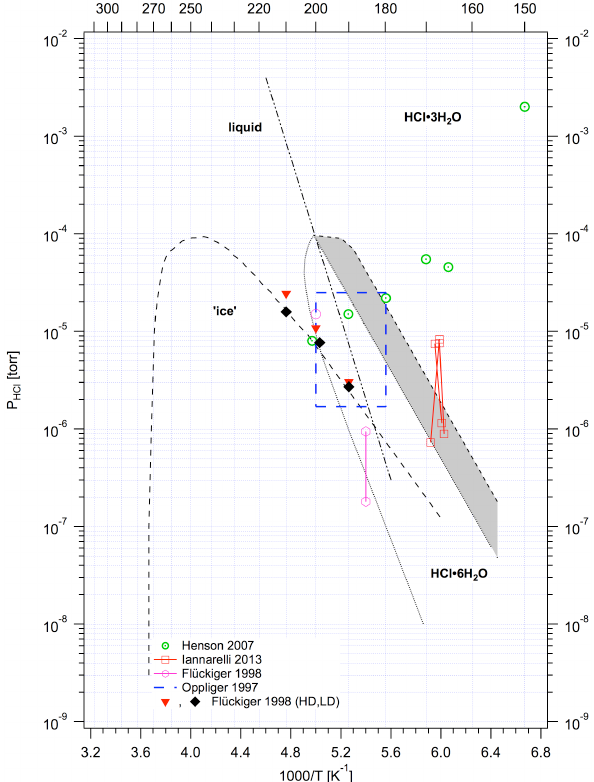
Figure 11. Phase diagram for the binary system HCl/H 2 O. The gray area for the HCl•6H 2 O existence is an extension of the existence area proposed by Iannarelli et al. (2013). The green circles represent HH evaporation whereas the red circles (amorphous HCl/H 2 O) and blue squares (crystalline HCl•6H 2 O) represent phase transition experiments. The colored lines represent individual experiments at stirred-flow conditions. The squares indicate the presence of a crystalline HCl•6H 2 O phase, while the circles represent amorphous HCl/ice as indicated by the corresponding FTIR spectra. The juxtaposition of red circles/blue squares in the “ice” existence area corresponds to simultaneous observations of HH and amHCl/H 2 O. The vertical red bar at T = 173 K indicates the stability limit of HCl•6H 2 O. The disordered/non-disordered (crystalline) limit follows data by McNeill et al. (2006).